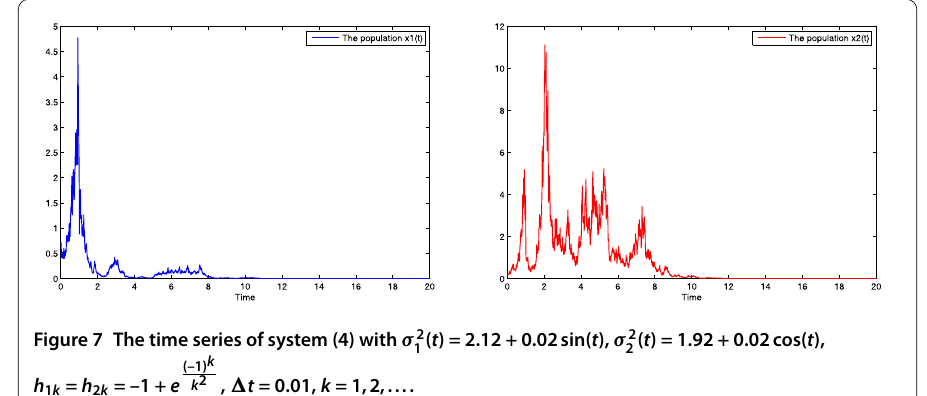
Figure 7 The time series of system (4) with σ 2